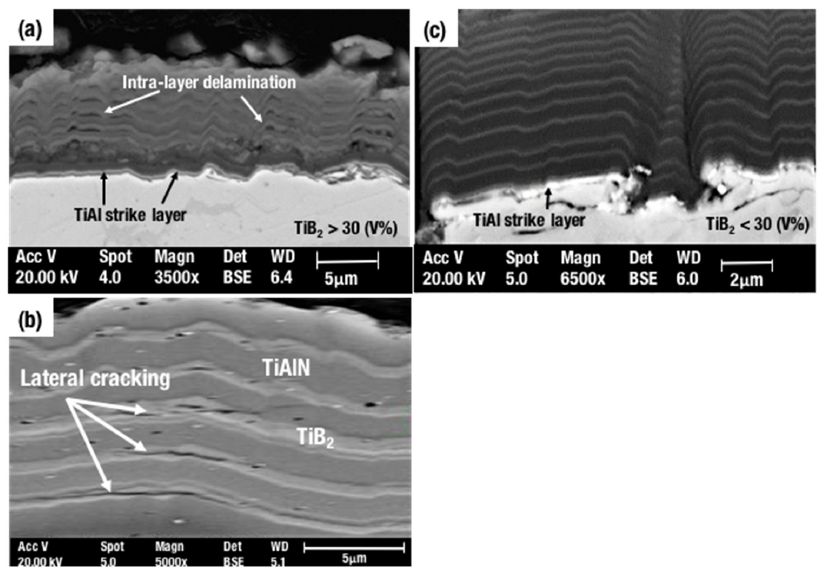
Figure 5. SEM images of cross ‐ sectional TiAlN/TiB 2 multilayer coatings. The light ‐ coloured bands in the images are from TiB2. Image ( a ) is from a coating where the TiB 2 content is greater than 30%, producing intra ‐ layer delamination at the TiAlNi/TiB 2 ; ( b ) Cross ‐ section of the coating showing the lateral cracks formed in the TiB 2 layers; Image ( c ) shows a coating with no intra ‐ layer delamination when TiB 2 is below 30%.